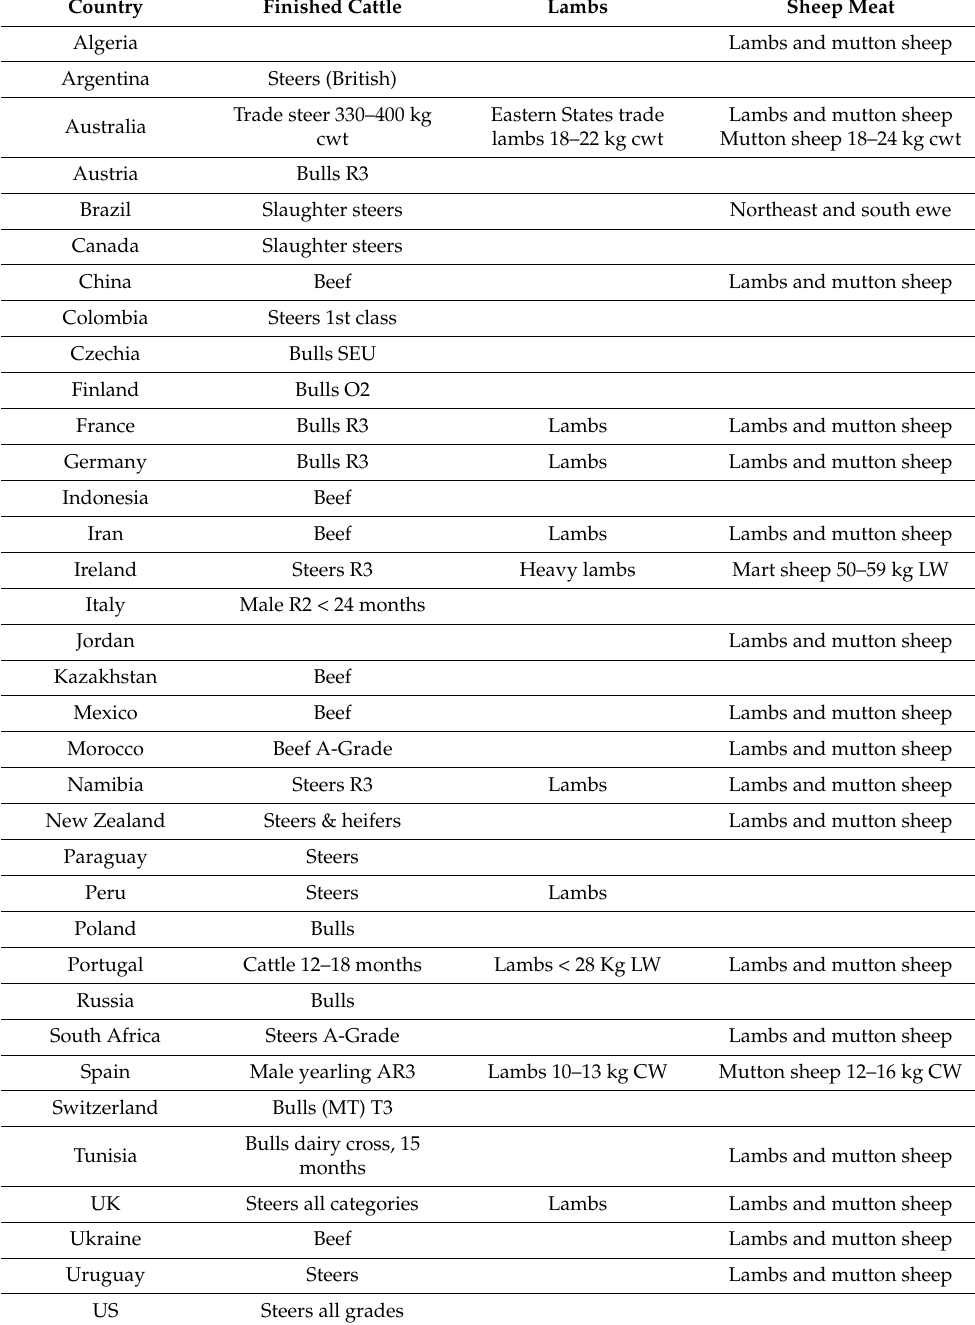
Table A2. Products selected as typical outputs for finished cattle, lambs, and sheep meat in the agri benchmark Beef and Sheep Network, source: own